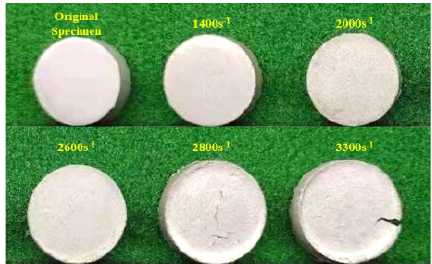
Figure 7. The specimens after dynamic compression at different strain rates at 20 ◦